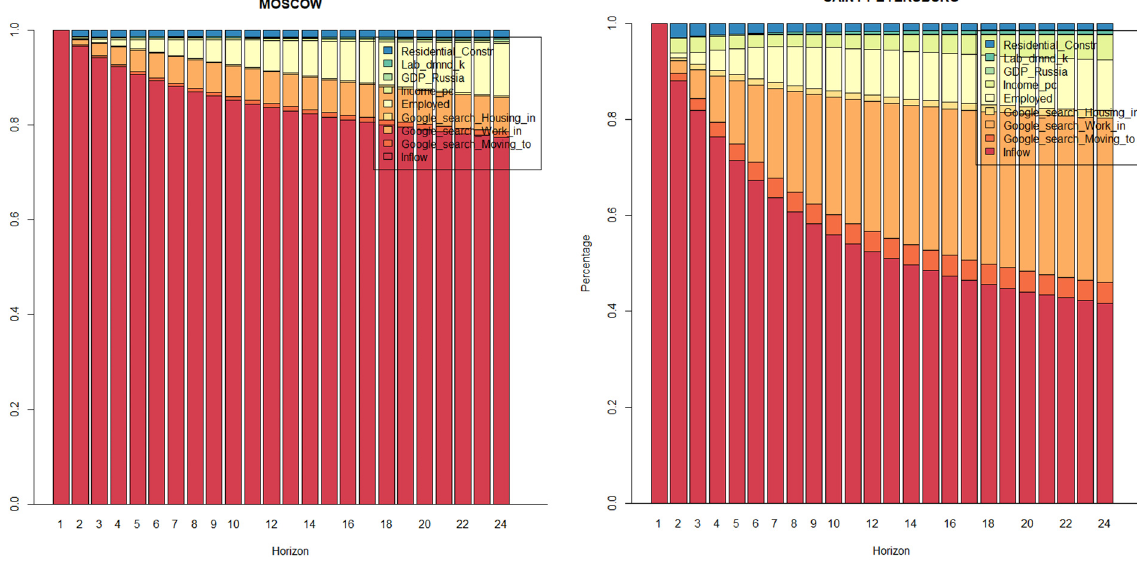
Figure 5. Forecast error variance decomposition of the VAR (1) with centered seasonal dummies: Moscow ( left panel ); Saint Petersburg ( right panel ).